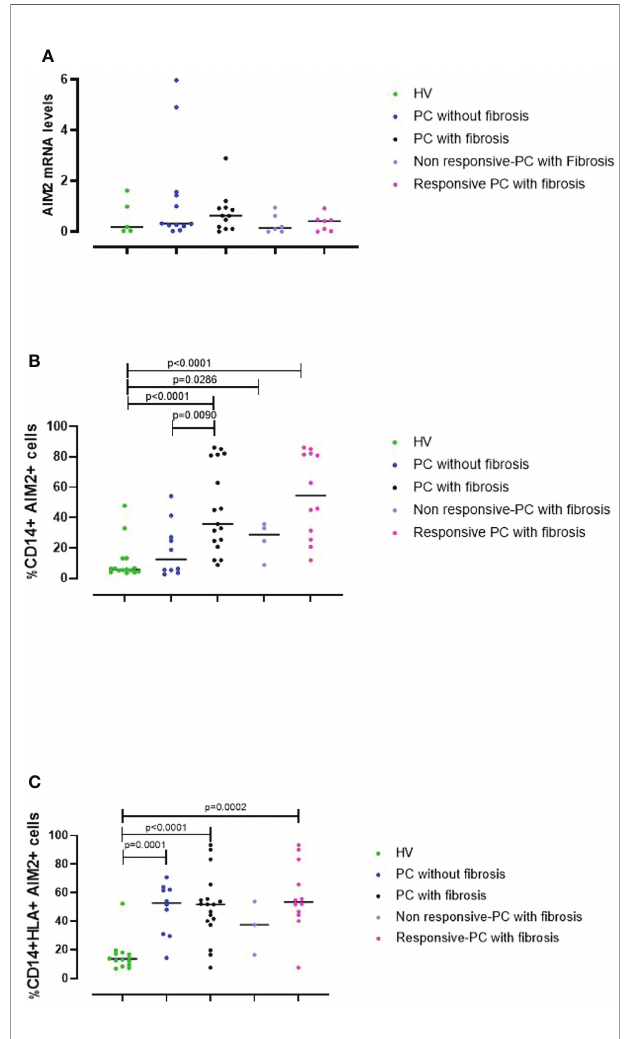
FIGURE 5 | AIM2 expression in circulating cells. (A) The levels of AIM2 mRNA in PBMCs obtained from Healthy Vaccinated (HV) subjects (green dots), post-COVID-19 (PC) patients without (blue dots) and with fi brosis (black dots) were evaluated using RT-PCR. PC patients with fi brosis were strati fi ed according to their responsiveness (release of cytokines) to Poly dA: dT stimulation, as non-responsive (light purple dots) or responsive (pink dots). PBMCs from the same groups were analyzed by fl ow cytometry for (B) CD14 + AIM2 + and (C) CD14 + HLA + AIM2 + expression. Data are reported as median and represented as scatter dot plots. Statistical analysis was performed using the Mann – Whitney U